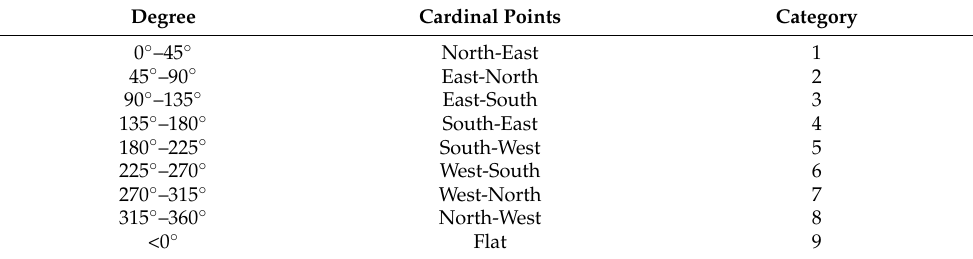
Table 2. Aspect categorization.